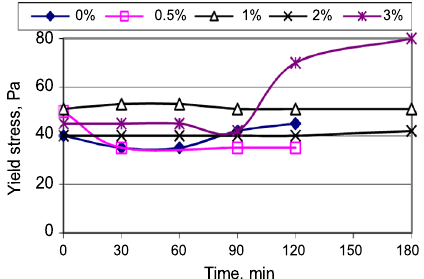
Fig. 10. Cement paste with CEM I R cement yield point